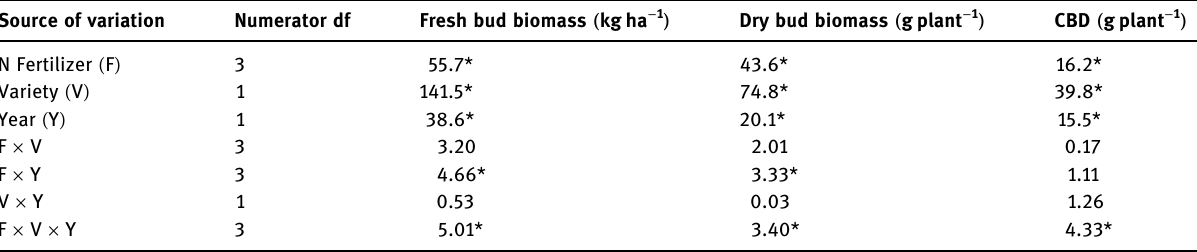
Table 1: Degrees of freedom, F - value, and signi fi cance level for the e ff ects of N fertilizer rate, variety, and year on fresh bud biomass, dry bud biomass, and CBD yield in 2019 and 2020 Source of